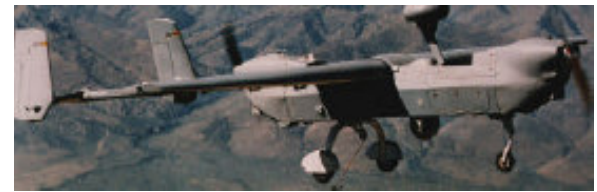
Fig. 1. Side view of the Hunter UAV